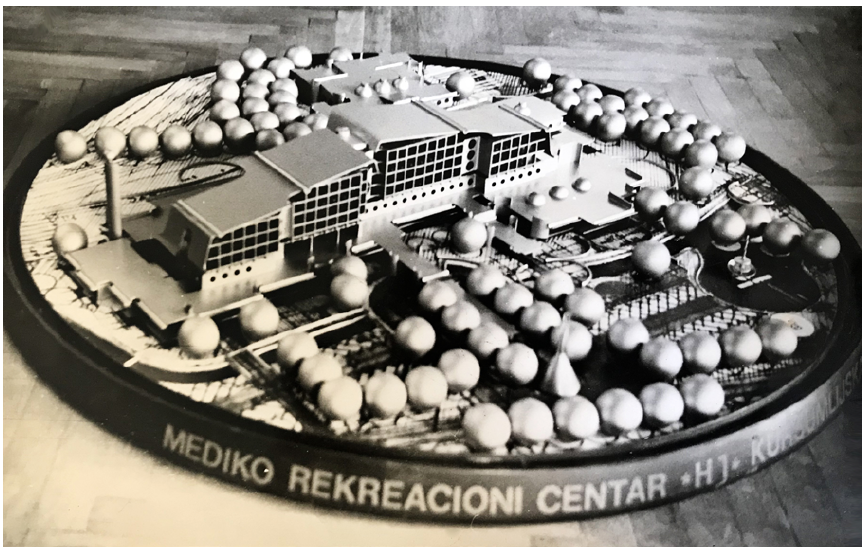
Franc Avbelj et al., Model of Medical and Recreational Center H1 in Kuršumlija Spa (1973) (Source: Private